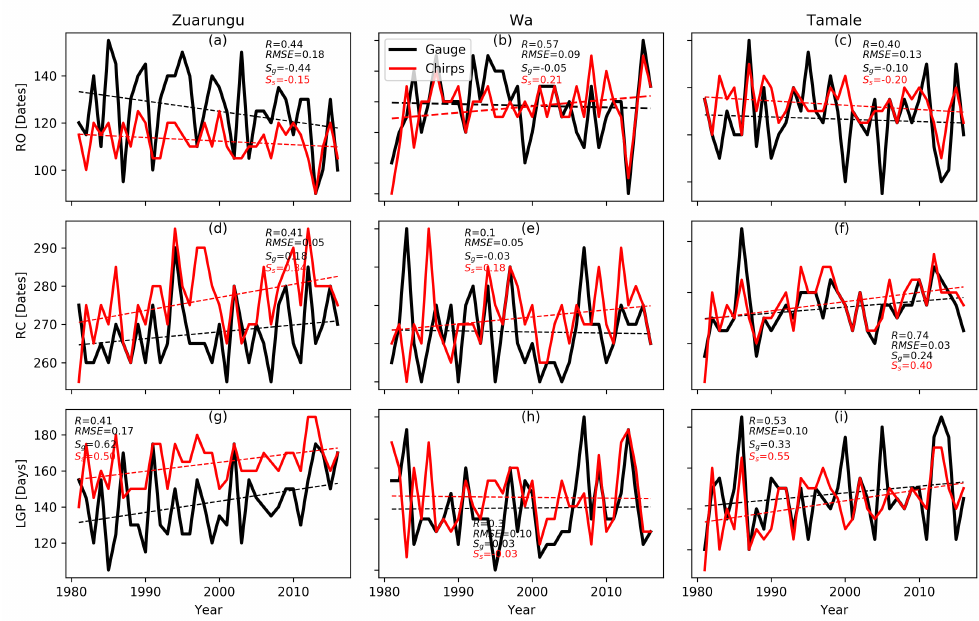
Figure 8. Trends of rainfall onset (RO), cessation (RC) date and LGP captured by gauge and satellite data in the UER, UWR, and NR from 1981 through 2016. Sg and Ss are the slope of linear regression for the gauge, and satellite,